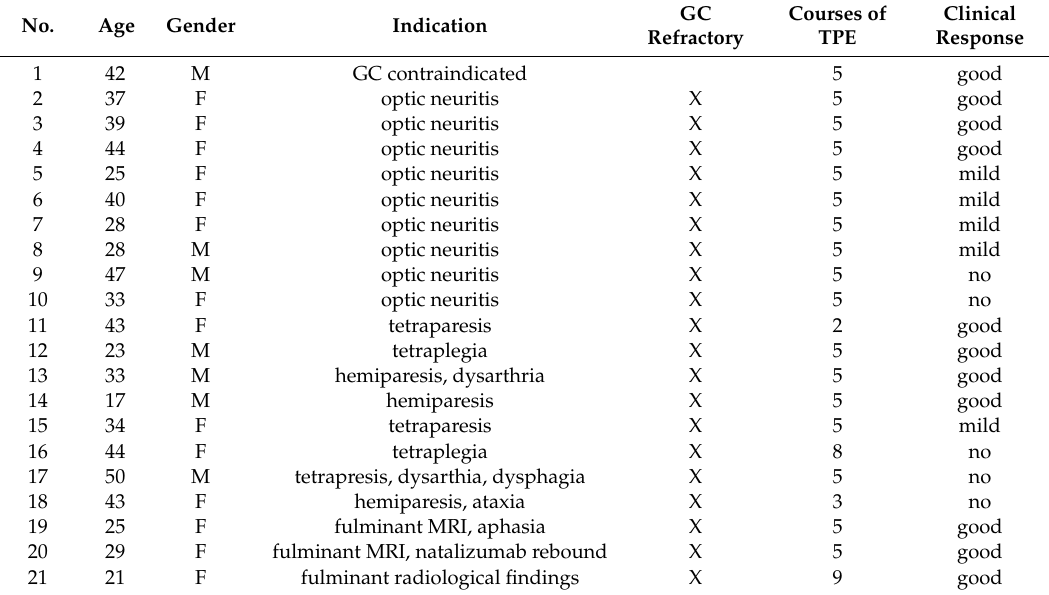
Table 1. TPE in patients with multiple